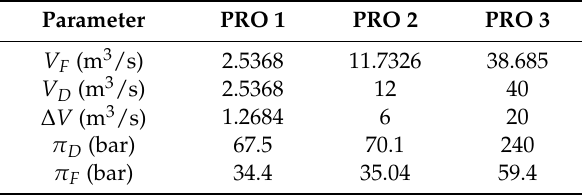
Table 2. Data for the three proposed PRO power